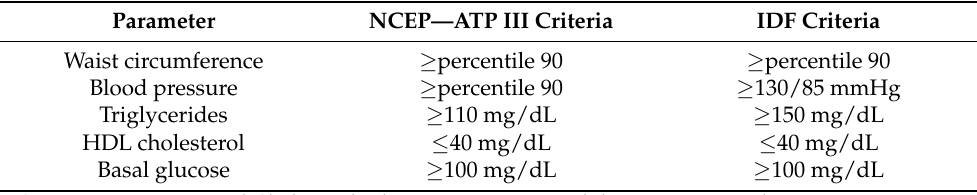
Table 1. Diagnostic criteria for metabolic syndrome in the pediatric population. Parameter NCEP—ATP III Criteria IDF Criteria Waist circumference ≥ percentile 90 ≥ percentile 90 Blood pressure ≥ percentile 90 ≥ 130/85 mmHg Triglycerides ≥ 110 mg/dL ≥ 150 mg/dL HDL cholesterol ≤ 40 mg/dL ≤ 40 mg/dL Basal glucose ≥ 100 mg/dL ≥ 100